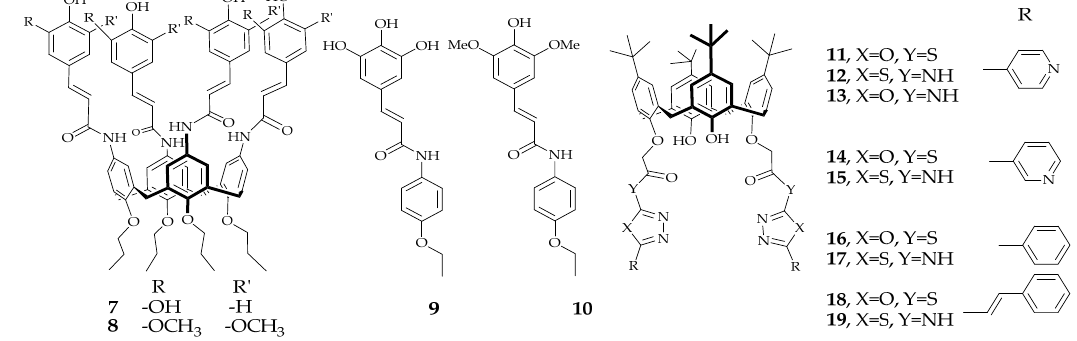
Figure 3. Structures of calix[4]arene derivatives 7 – 19 .